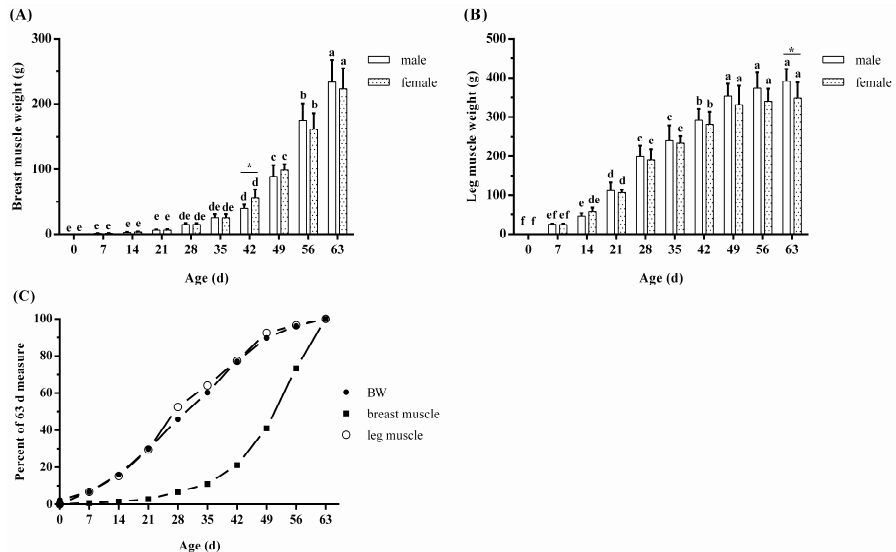
Figure 3. The dynamic change of breast muscle ( A ) and leg muscle ( B ) for male and female goslings from hatching to 63 d of age. Values are given as means and standard deviation (n = 8). Values followed by different letters (a–f; age) or * (sex) differ significantly ( p < 0.05). ( C ) Fractional growth of BW and breast and leg muscle weights as a proportion of the measure at 63 d of age. Means represent 16 birds per age (combined male and female).